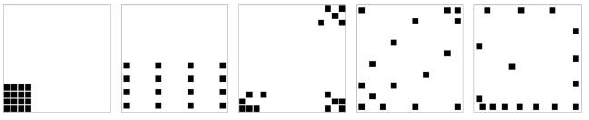
Figure 6 . Manual samples compared in Figure 4. From left to right: 0; 12; 13; 16; 21. Figure 7 . Graphs comparing 5 manual samples for the 6 available parameters. Each graph shows a single parameter (y axis) plotted for all the iterations (x axis) up to reaching its limit value. a) Object number; b) Void area; c) Void number; d) Point distance; e) H-index; f)